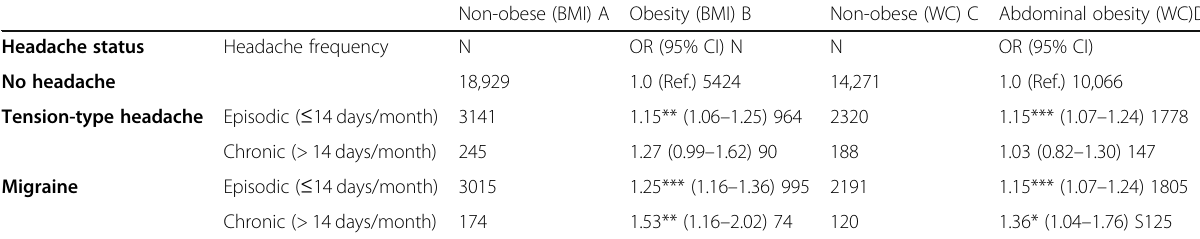
Table 4 Obesity by headache